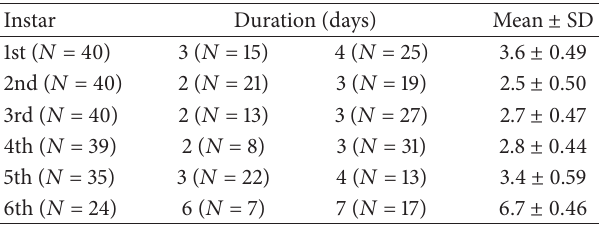
Table 1: Larval stages duration of Cosmosoma auge raised at Coj´ımar, Havana, under laboratory conditions (September-October